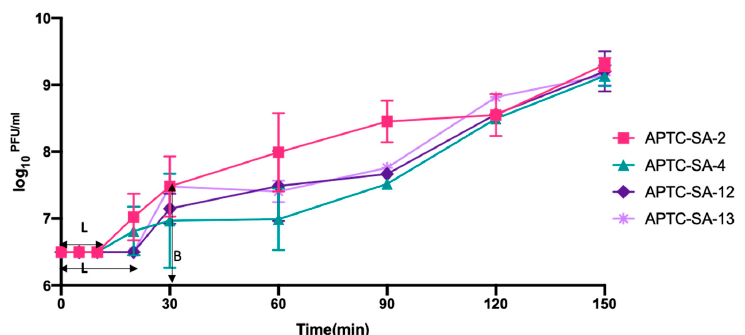
Figure 2. One-step growth curves of S. aureus phages. The log 10 PFU/mL of phages in the cultures at different time points were tested. Each data point represents the mean from three independent experiments, and the error bars indicate SD. L = the latent period; B = burst size. S. aureus ATCC25923 was used to perform the in vitro phage inhibition assay with phage at MOI = 0.1 and 1, or MOI = 0 (no phage) as positive control. APTC-SA-2 at MOI = 1 and 0.1 reduced the bacterial growth at the 90 min and 120 min time points, respectively (Figure 3A), while ATPC-SA-4 reduced S. aureus growth at the 90 min time point for both MOI = 1 and MOI = 0.1 ( p < 0.05) (Figure 3B). The effect of ATPC-SA-12 and ATPC-SA-13 on reducing the growth of S. aureus occurred at a later time point compared to APTC-SA- 2 and APTC-SA-4, with APTC-SA-12 inhibiting the growth of S. aureus at 120 min (MOI = 1) and 180 min (MOI = 0.1), respectively (Figure 3C), and APTC-SA-13 at 150 min (MOI = 1) and 180 min (MOI = 0.1) ( p < 0.05) (Figure 3D).